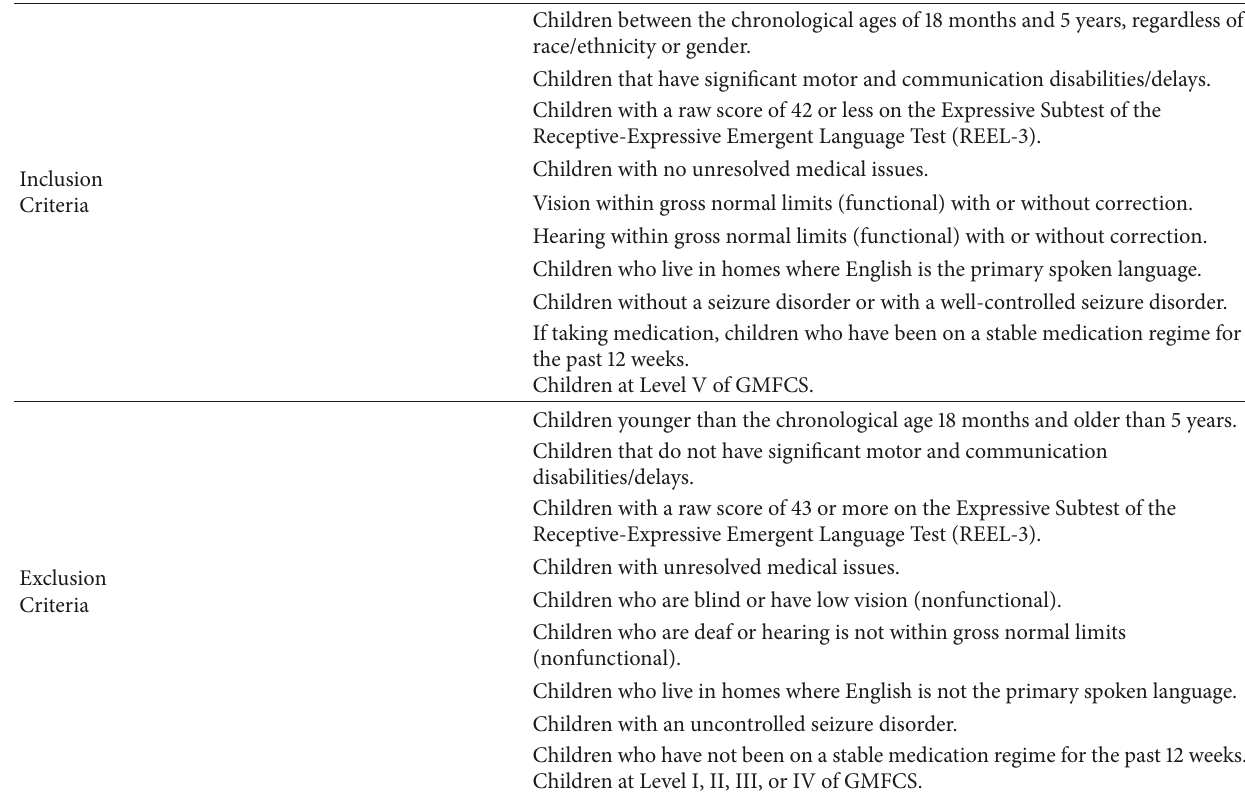
Table 2: Inclusion and exclusion criteria for recruited subjects.